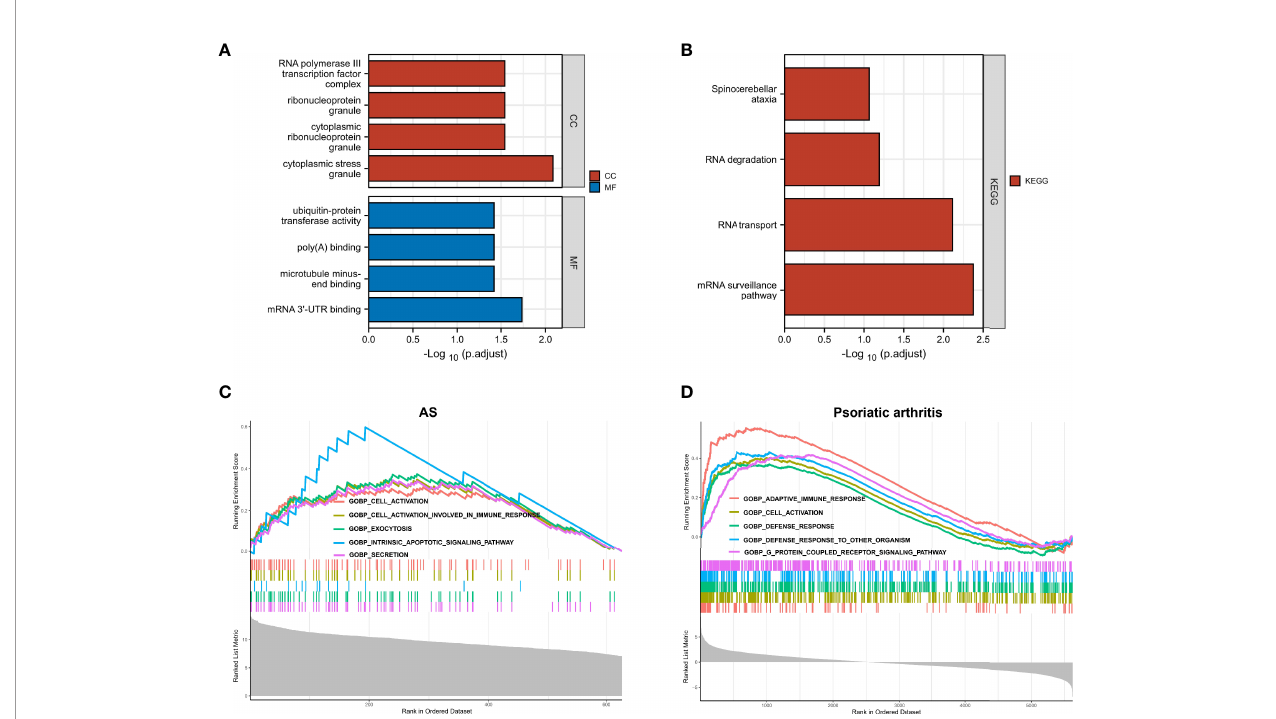
FIGURE 4 | (A) GO enrichment analysis results for 9 genes screened by WGCNA. (B) KEGG enrichment analysis results for 9 genes screened by WGCNA. (C) Single-gene GSEA analyses results for DEGs of AS. (D) Single-gene GSEA analyses results for DEGs of PsA.